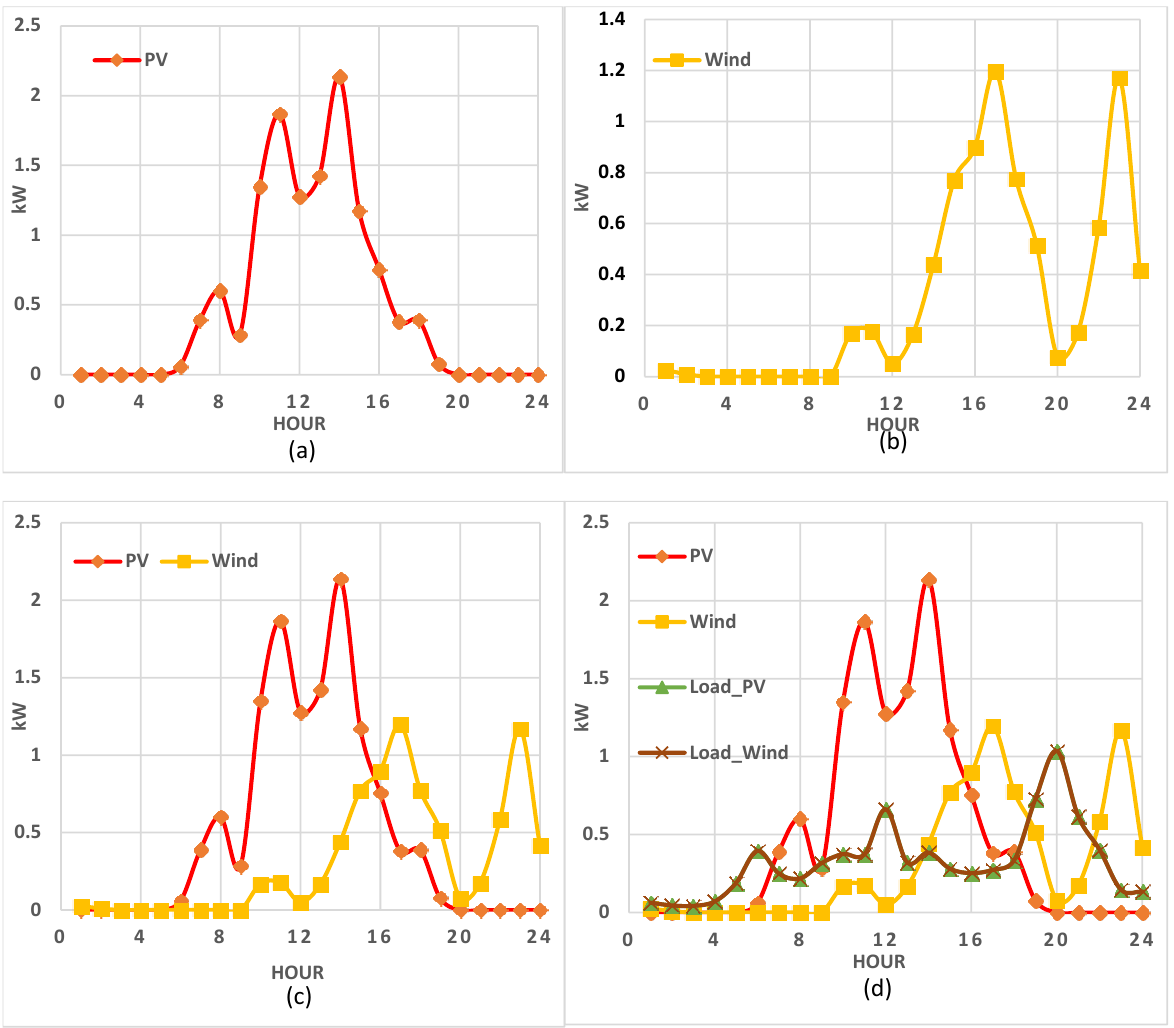
Figure 8. Daily load profile of prosumers in a typical day in July: ( a ) PV generation; ( b ) Wind turbine generation; ( c ) Combined generation: ( d ) Combined generation with consumption .